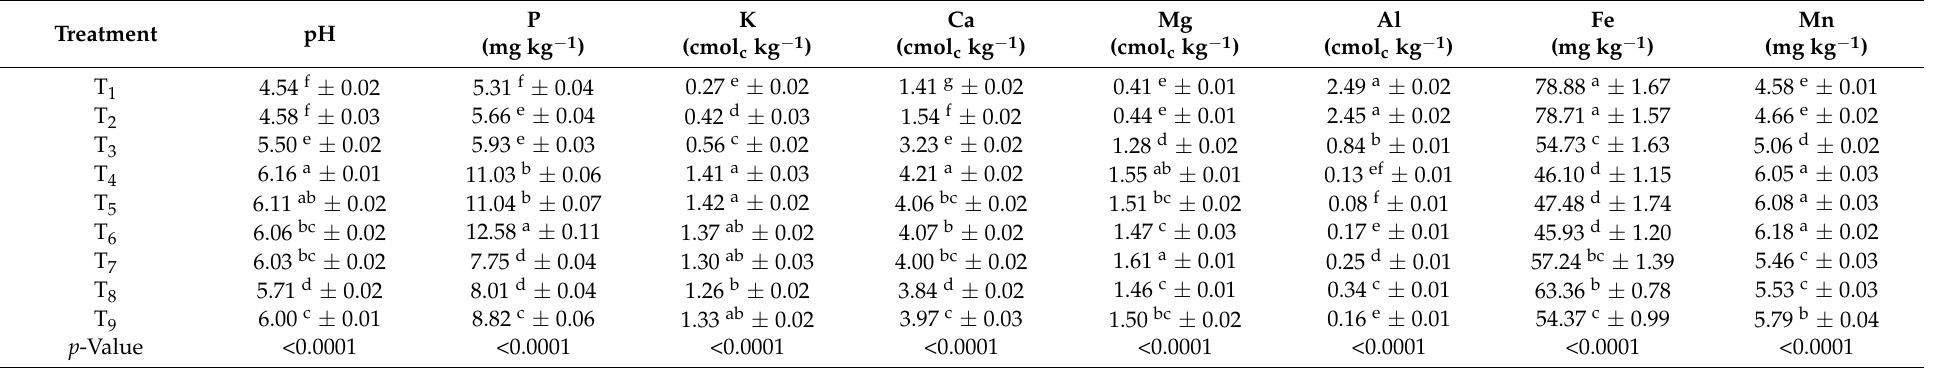
Table 2. Effect of treatments on nutrients of the post-harvest